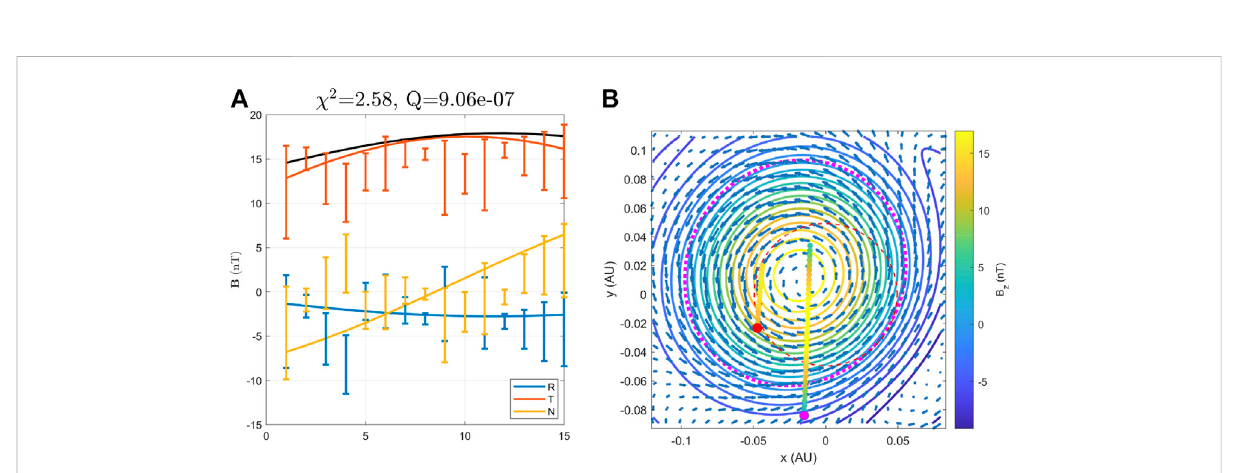
FIGURE 8 (A) The two-spacecraft (STA-PSP) optimization result of the magnetic fi eld components and magnitude (black curve) for the STA data interval. Format is the same as Figure 4. (B) One cross section for the optimal FS model result based on the two-spacecraft (STA-PSP) optimization (with a =0.049 AU). Format is the same as Figure